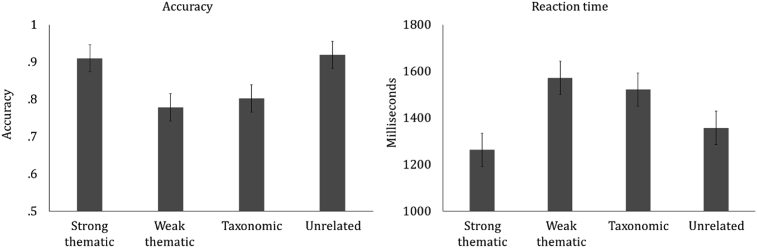
Accuracy and RT for catch-trial data in the taxonomic, strong thematic, weak thematic and unrelated conditions respectively. Error bars show SE.